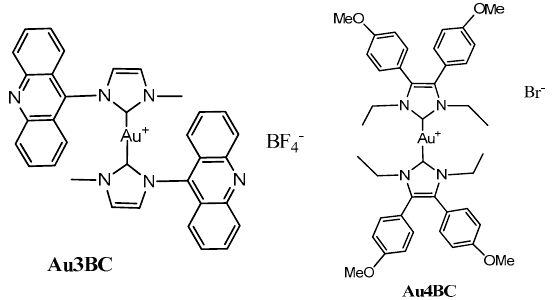
Figure 1. Chemical structures of the selected complexes Au3BC and Au4BC.